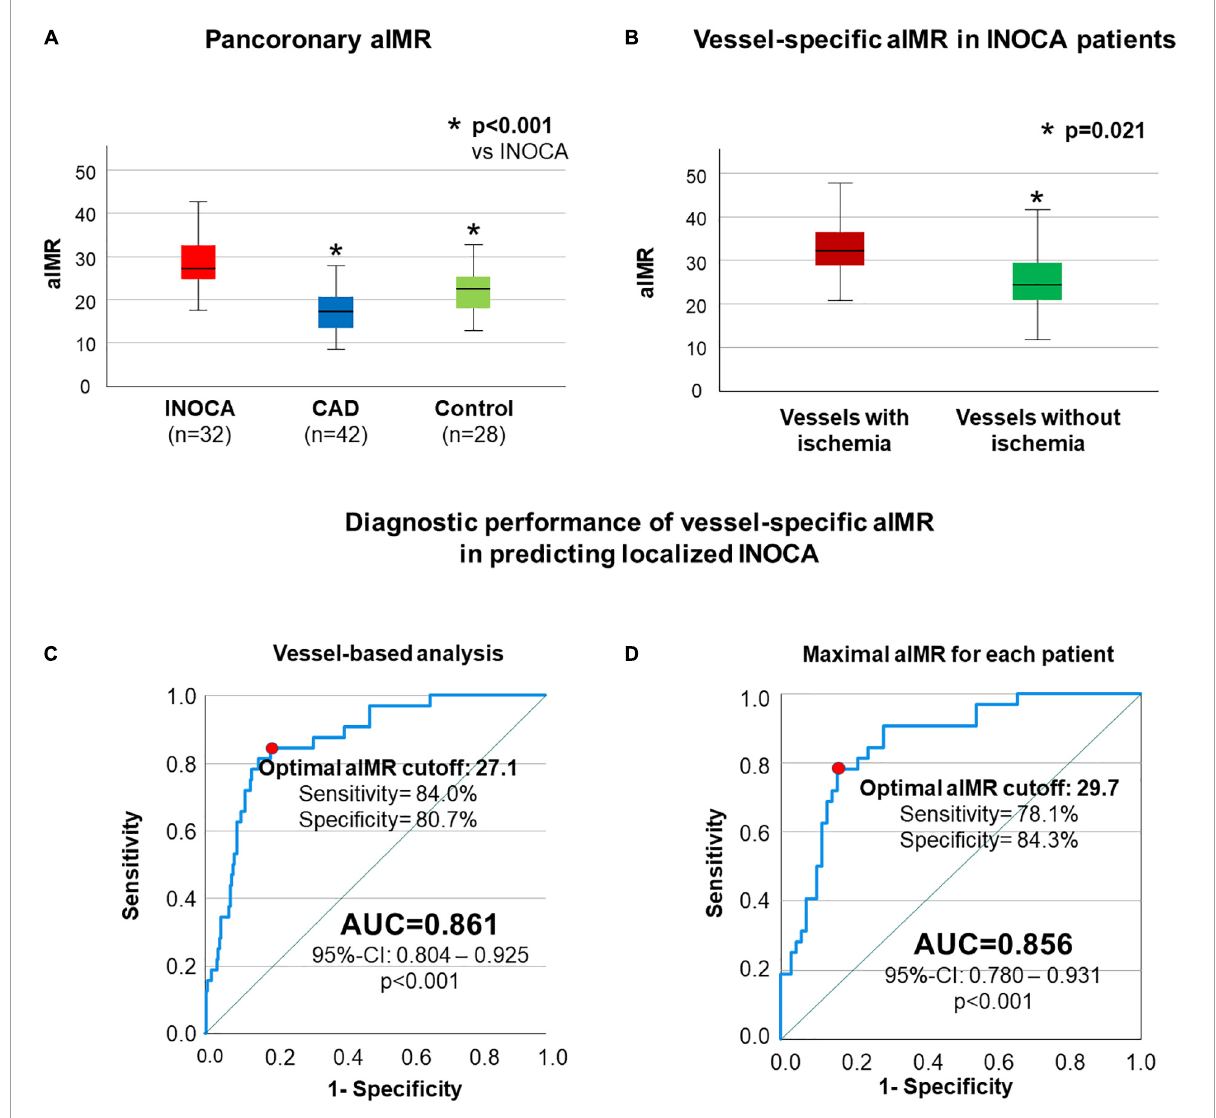
FIGURE1 aIMR is higher in INOCA patients and vessels supplying ischemic myocardium. In (A) a significantly higher pancoronary aIMR in patients with INOCA compared to both CAD and control patients is shown. In (B) a comparison between single-vessel aIMR in INOCA patients is reported, showing significantly higher aIMR in vessels supplying ischemic myocardium compared to the rest of the coronary tree. ROC-analysis assessing vessel-specific aIMR in order to predict ischemia in cMRI in the supplied myocardium without obstructive CAD is shown in (C , D) including in the analysis all coronary vessels (C) or only the vessels with maximal aIMR for each patient (D) .